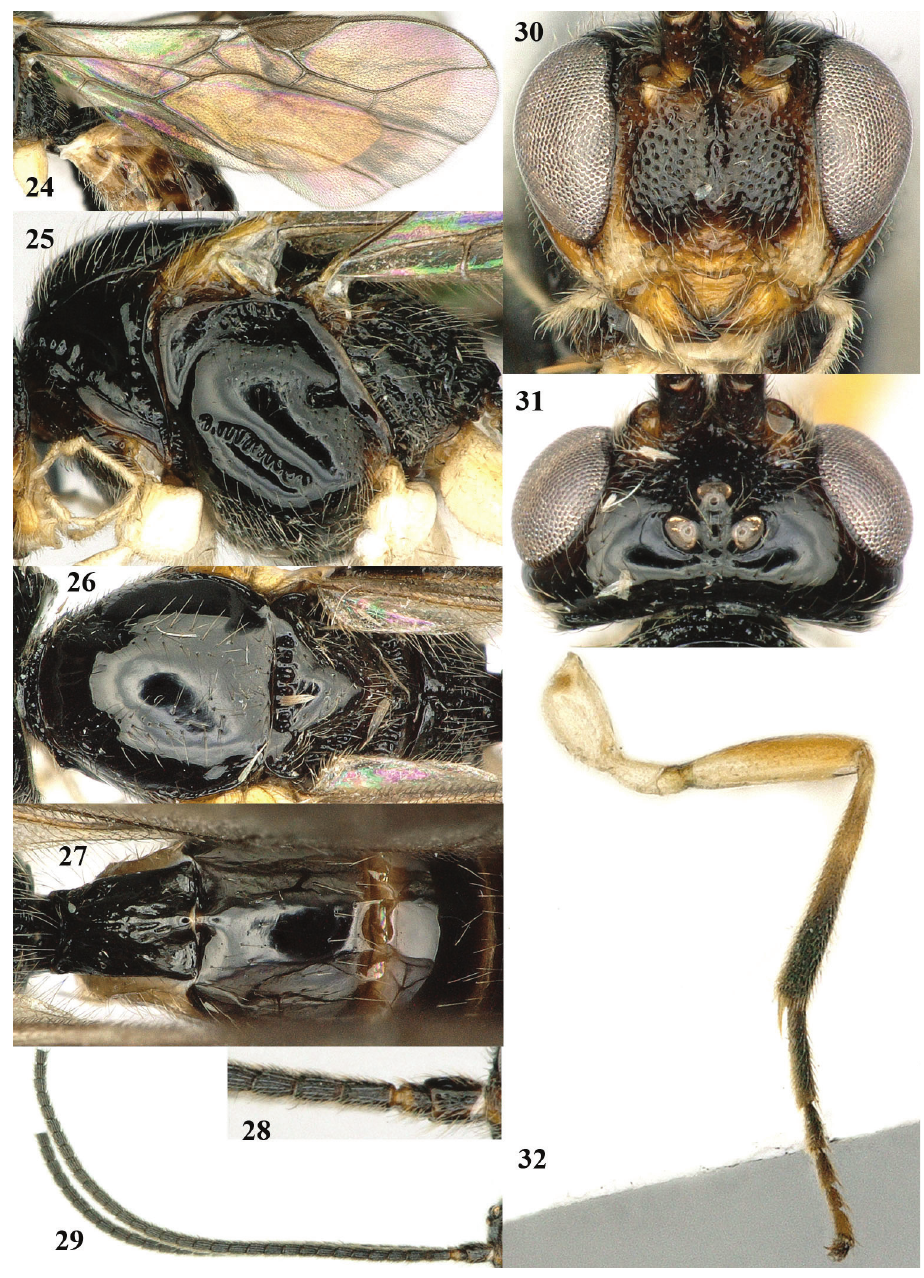
Figures 24–32. Rhogadopsis longivena sp. n., female, holotype. 24 wings 25 mesosoma lateral 26 meso- soma dorsal 27 first-fourth metasomal tergites dorsal 28 base of antenna 29 antenna 30 head anterior 31 head dorsal 32 hind